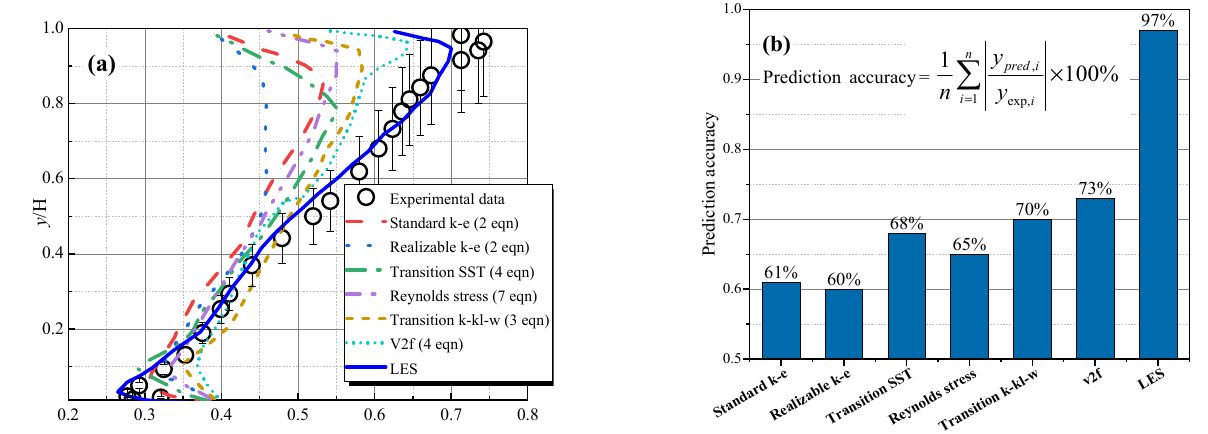
Figure 5. Comparative analysis of the temperature prediction accuracy of different turbulence models. ( a ) Comparison of selected experimental data and results of each turbulence model; ( b ) distribution of prediction accuracy of each turbulence model.